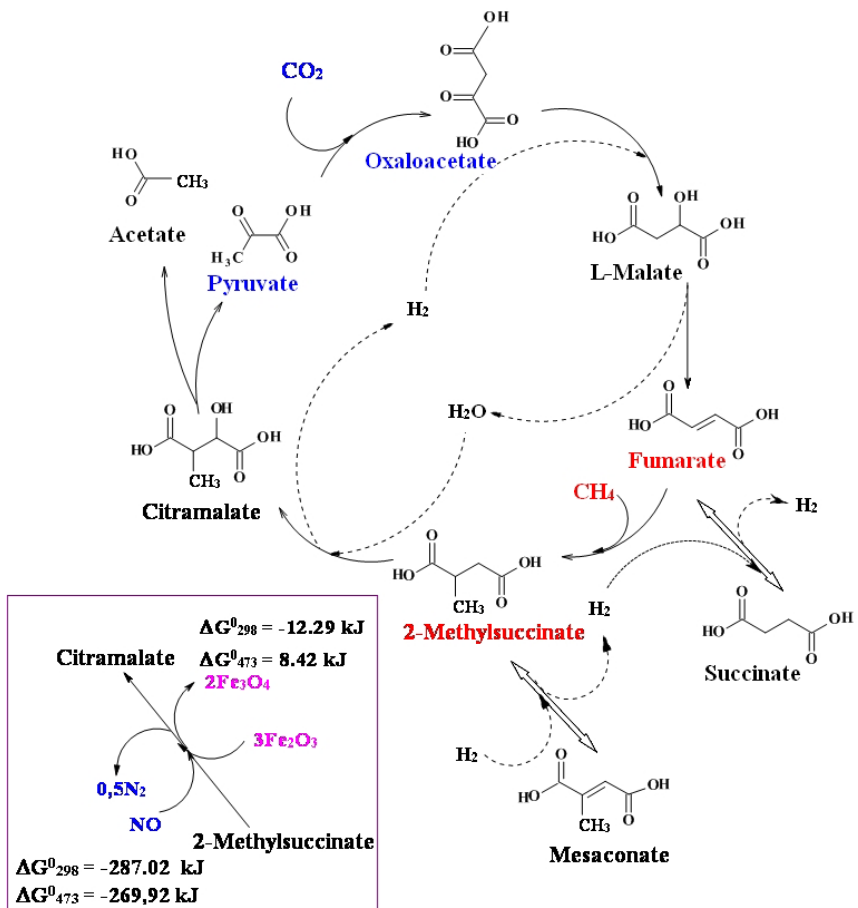
Figure 2. The scheme of the proposed methane–fumarate (MF) cycle. Carbon from methane is introduced into the fumarate (marked by red), and that from CO 2 is introduced into the pyruvate (marked by blue) with the formation of a C–C bond. The reaction sequence pyruvate → ox- aloacetate → malate → fumarate → succinate is part of the reductive tricarboxylic acid (rTCA) cycle, an enzyme-free archaic version which is proposed as the basis of ancient autotrophic metabolism (Wächtershäuser 1990; Smith and Morowitz, 2004). The inset shows options for the oxidative transformation of 2-methylsuccinate to citramalate with hematite (Fe 2 O 3 ) and nitric oxide (NO) as oxidants. The chemical potential of hydrogen in the environment determines the equilibrium shift in the reactions succinate ↔ fumarate and 2-methylsuccinate ↔